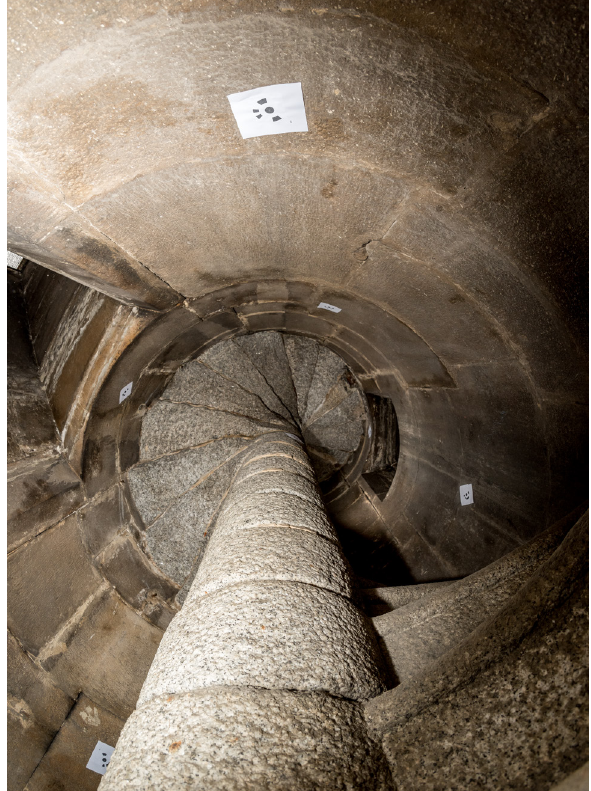
Figure 10. Five pictures which compose the capturing geometry, Figure 9 . Internal view of the Minguzzi staircase during the plus one detail picture (bottom right) of one photogrammetric survey.